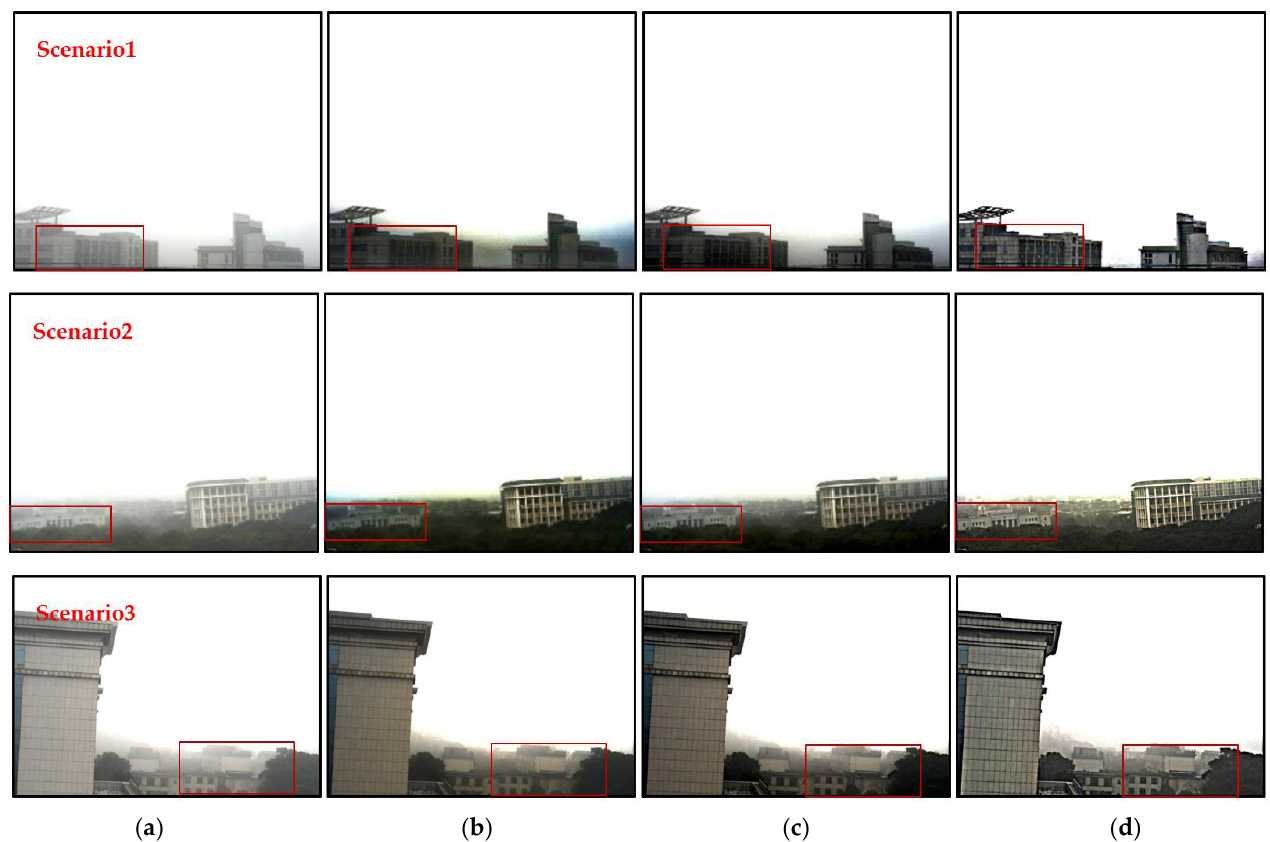
Figure 7. The comparison between different methods, ( a ) the original hazy image, ( b ) the result of dark channel, ( c ) the result of SIDMP, ( d ) the result of proposed method.